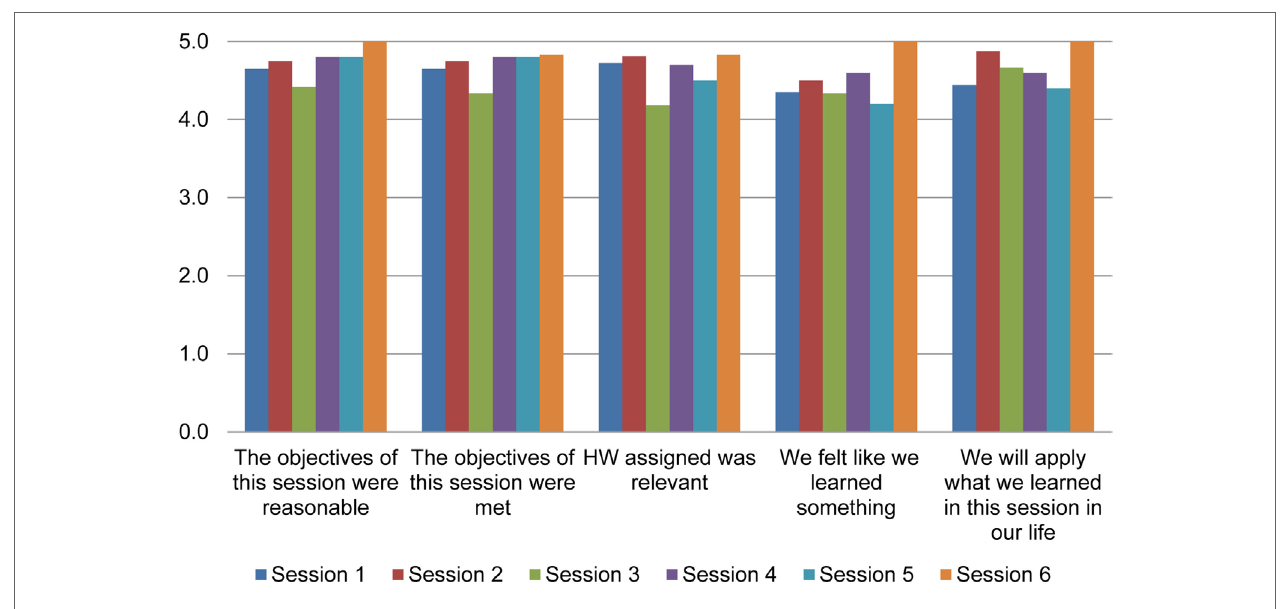
FigUre 3 | acceptability data